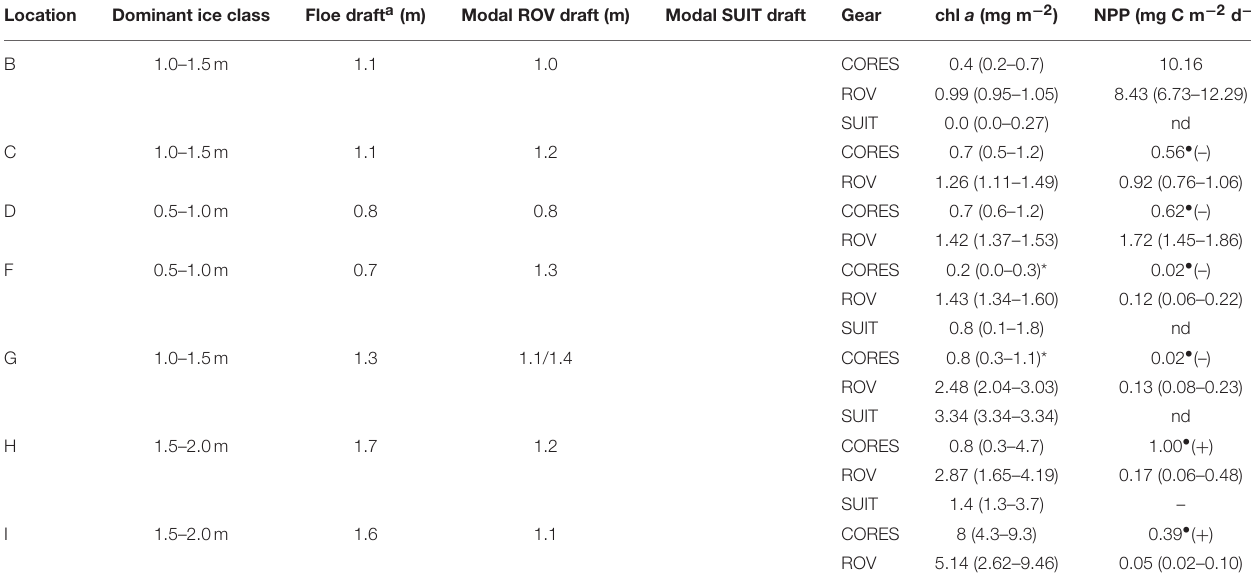
TABLE 3 | Modal sea ice draft from literature (Boetius et al., 2013; Katlein et al., 2015b) and ROV measurements, dominant ice class based on literature modal draft, interquartile range of chlorophyll a biomass observations for the dominant ice class using different gears (ice coring, ROV, and SUIT) summarized for each location. Location